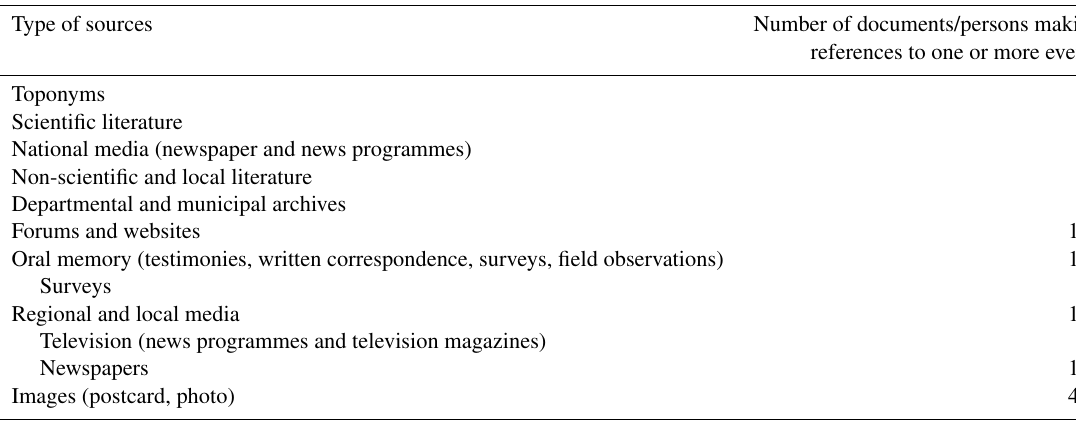
Figure 2. Overview of the set of geohistorical sources used in the present study. Table 2. Number of references to one or more events by type of